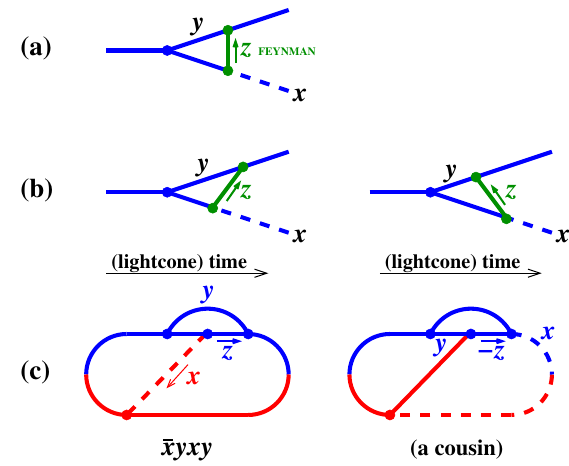
Figure 17 . (a) An ordinary Feynman diagram representing a one-loop vertex correction to single splitting g → gg , where we have highlighted the line z = 1 − x − y in green. (b) The two time orderings in LCPT for the transverse-polarization contributions to that Feynman diagram. (c) Examples of rate diagrams that involve those time orderings of the amplitude. (Other examples just correspond to different choices of how to time-order the splitting in the conjugate amplitude relative to the interactions in the amplitude.) The first diagram in (c), ¯ xyxy , is an example of a Class I virtual correction analyzed in ref. [19]. There, Class I diagrams must be added to their “cousins” obtained by swapping the two daughters of the splitting, x → 1 − x . The second diagram above is the cousin of the first, which can be seen by relabeling the loop variable y in the second diagram by y → 1 − y . We haven’t relabeled y here because that would destroy the correspondence of the label z = 1 − x − y in (c) with the labeling of the original Feynman diagram in